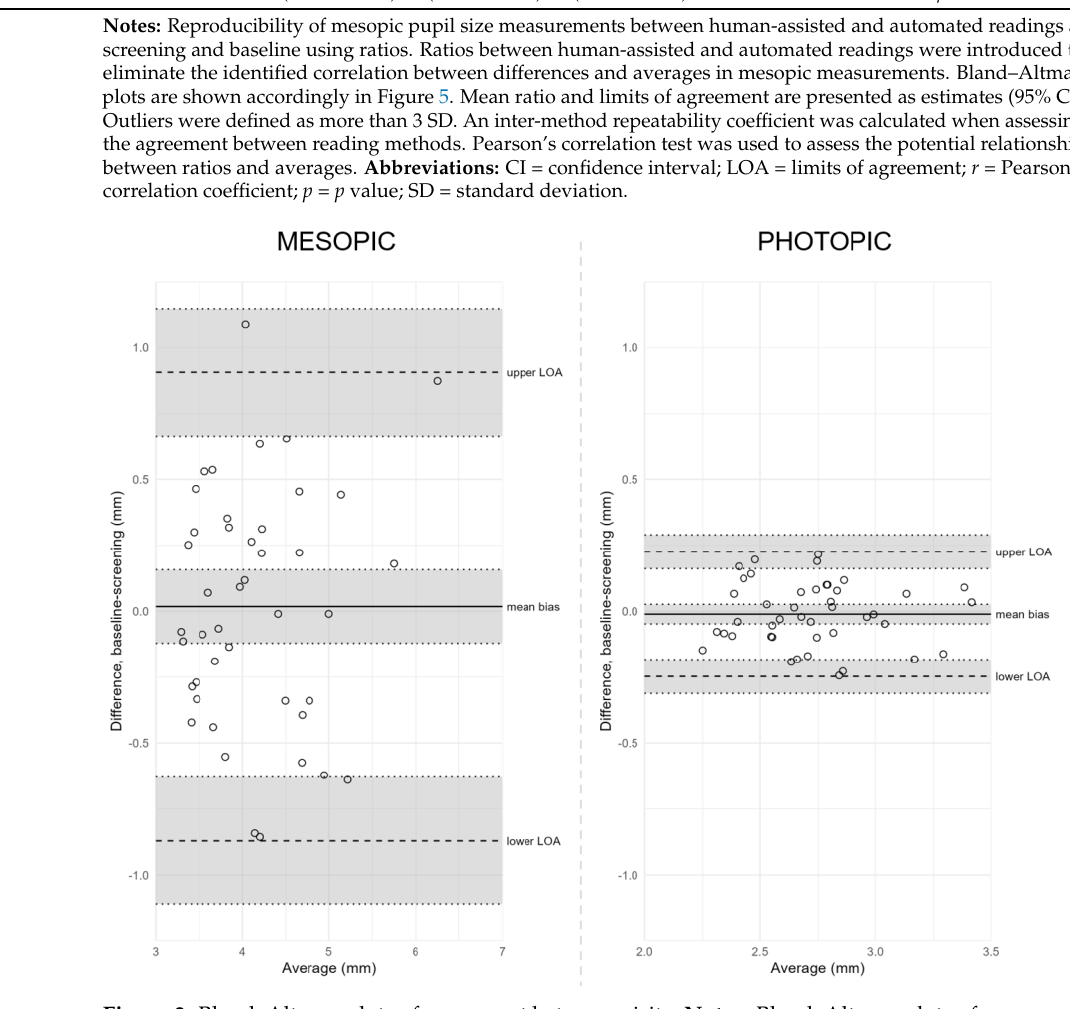
Figure 3. Bland–Altman plots of agreement between visits. Notes: Bland–Altman plots of agreement between human-assisted readings of screening and baseline measurements under mesopic (left) and photopic (right) conditions. Differences between measurements are plotted against their averages. The solid line marks the mean difference in pupil size between visits, the dashed lines mark the lower and upper limits of agreement (LOA), and grey shaded areas cover 95% CI of calculated estimates. Please note that the scales in Figures 3 and 4 are different. Abbreviations: CI = confidence interval; LOA = limits of